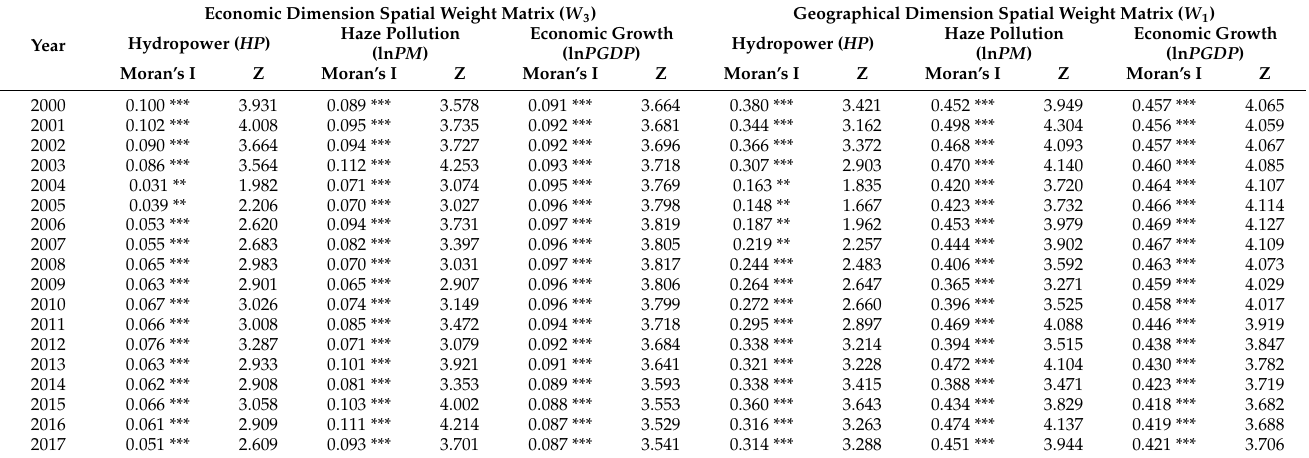
Table 3. 2000–2017 Moran’s I index of China’s provincial hydropower, haze pollution and economic